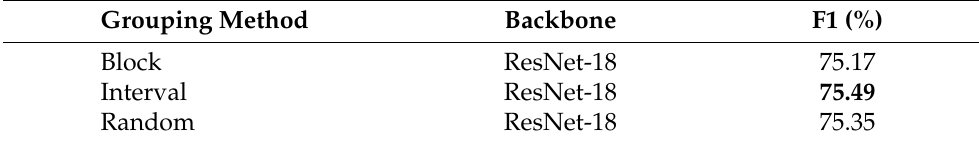
Table 7. The influence of different grouping methods on DFC. The best result is marked in